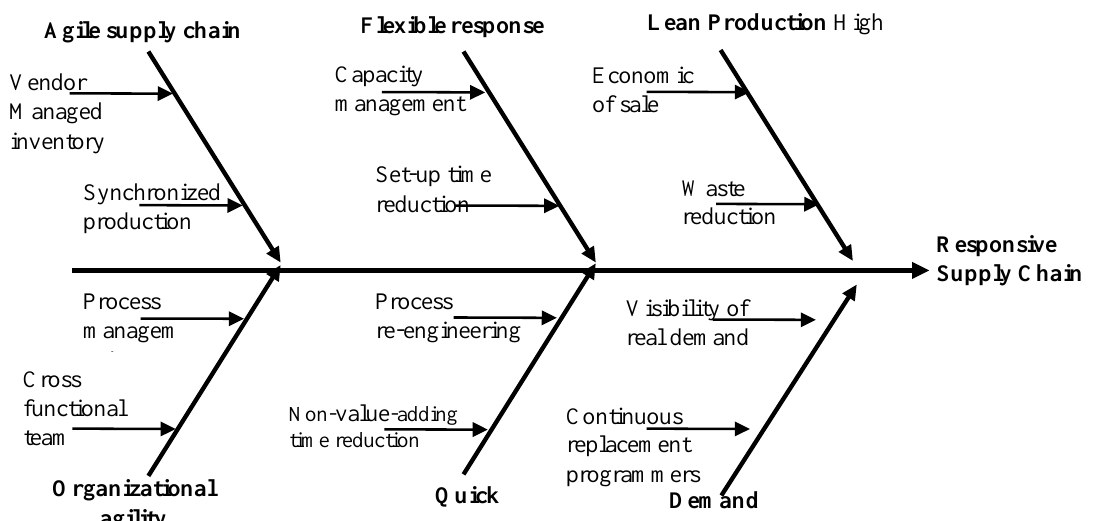
Fig. 4. Theoretical approach for responsive supply chain (Catalan & Kotzab 2003)